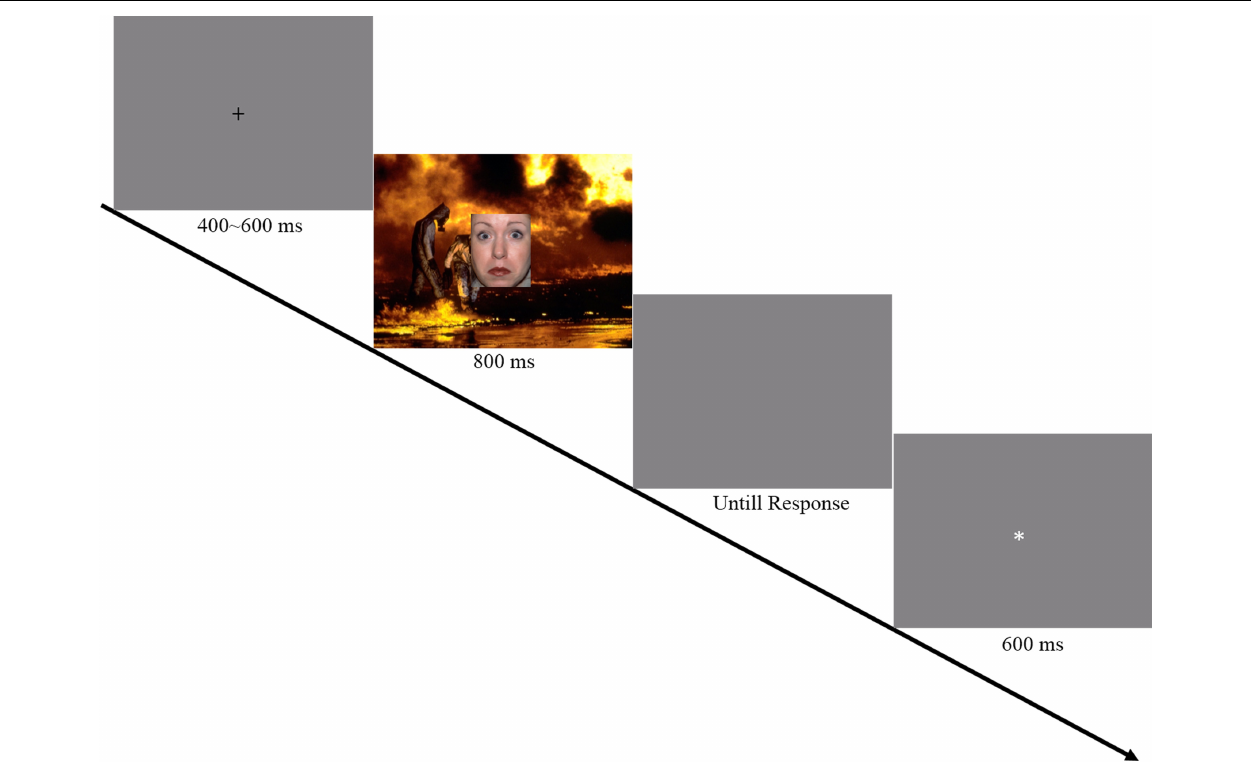
FIGURE 2 | Illustration of the experimental procedure. Fixation mark